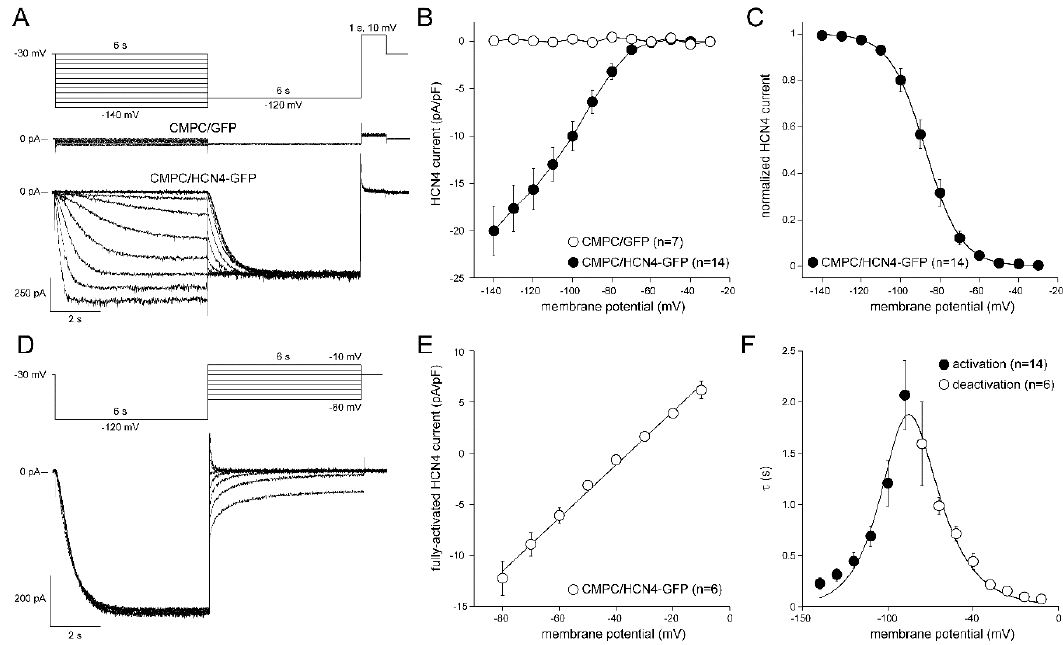
Figure 3. Pacemaker current, I f , in single LV-transduced CMPCs. ( A ) Voltage steps and typical I f